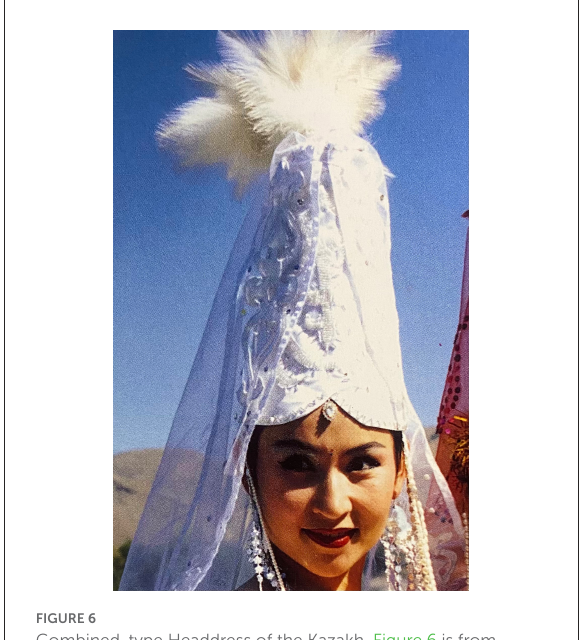
FIGURE6 Combined-type Headdress of the Kazakh. Figure 6 is from Xinjiang Uygur Autonomous Region Association for foreign cultural exchanges; Figures 7, 10 are from Chang (2005); Figure 9 is from Xinjiang Uighur Region Museum; Figures 8, 11 are from Burqa (2013), Drapery-Type Headdress in Arab (2019).